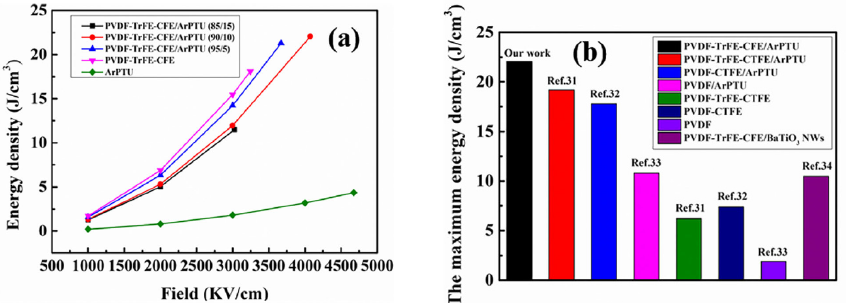
Figure 7. Energy density and breakdown data for mixed- polymer thin films. ( a ) The energy density of PVDF-TrFE-CFE/ArPTU composite films with different composite ratios; ( b ) Comparing of discharge energy density of our works with reported works [16].